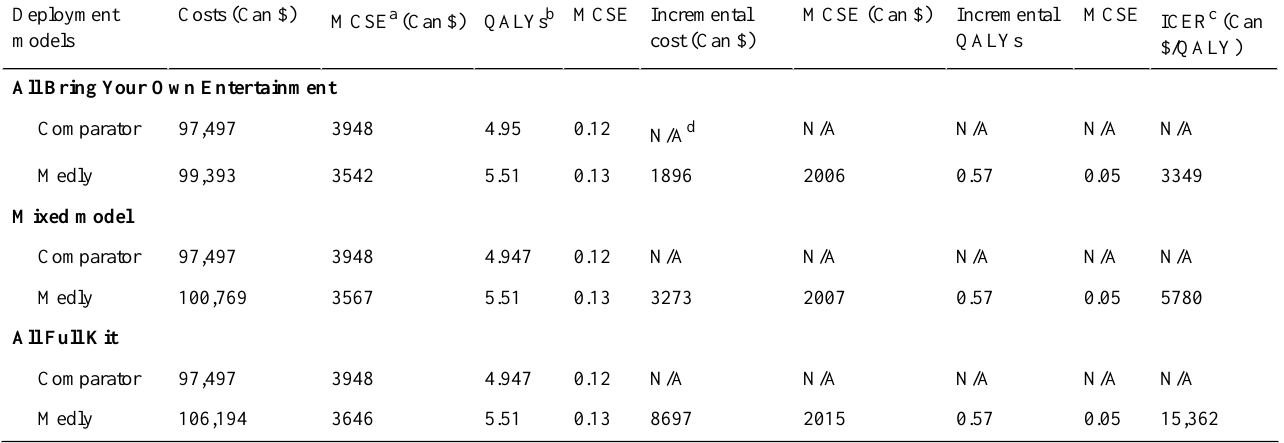
Table 7. Deterministic results for each deployment model of Medly.